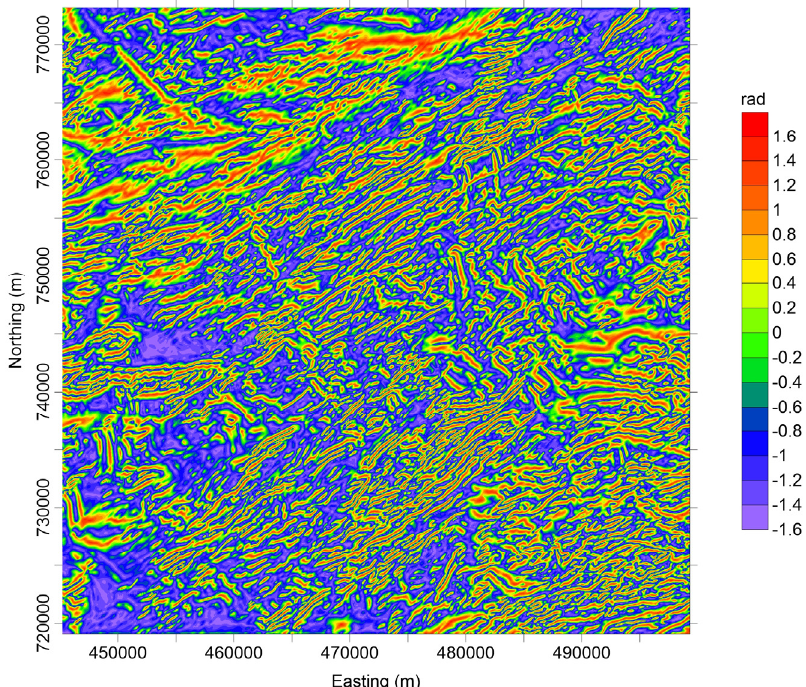
Figure 4. TAHG map of the study area.